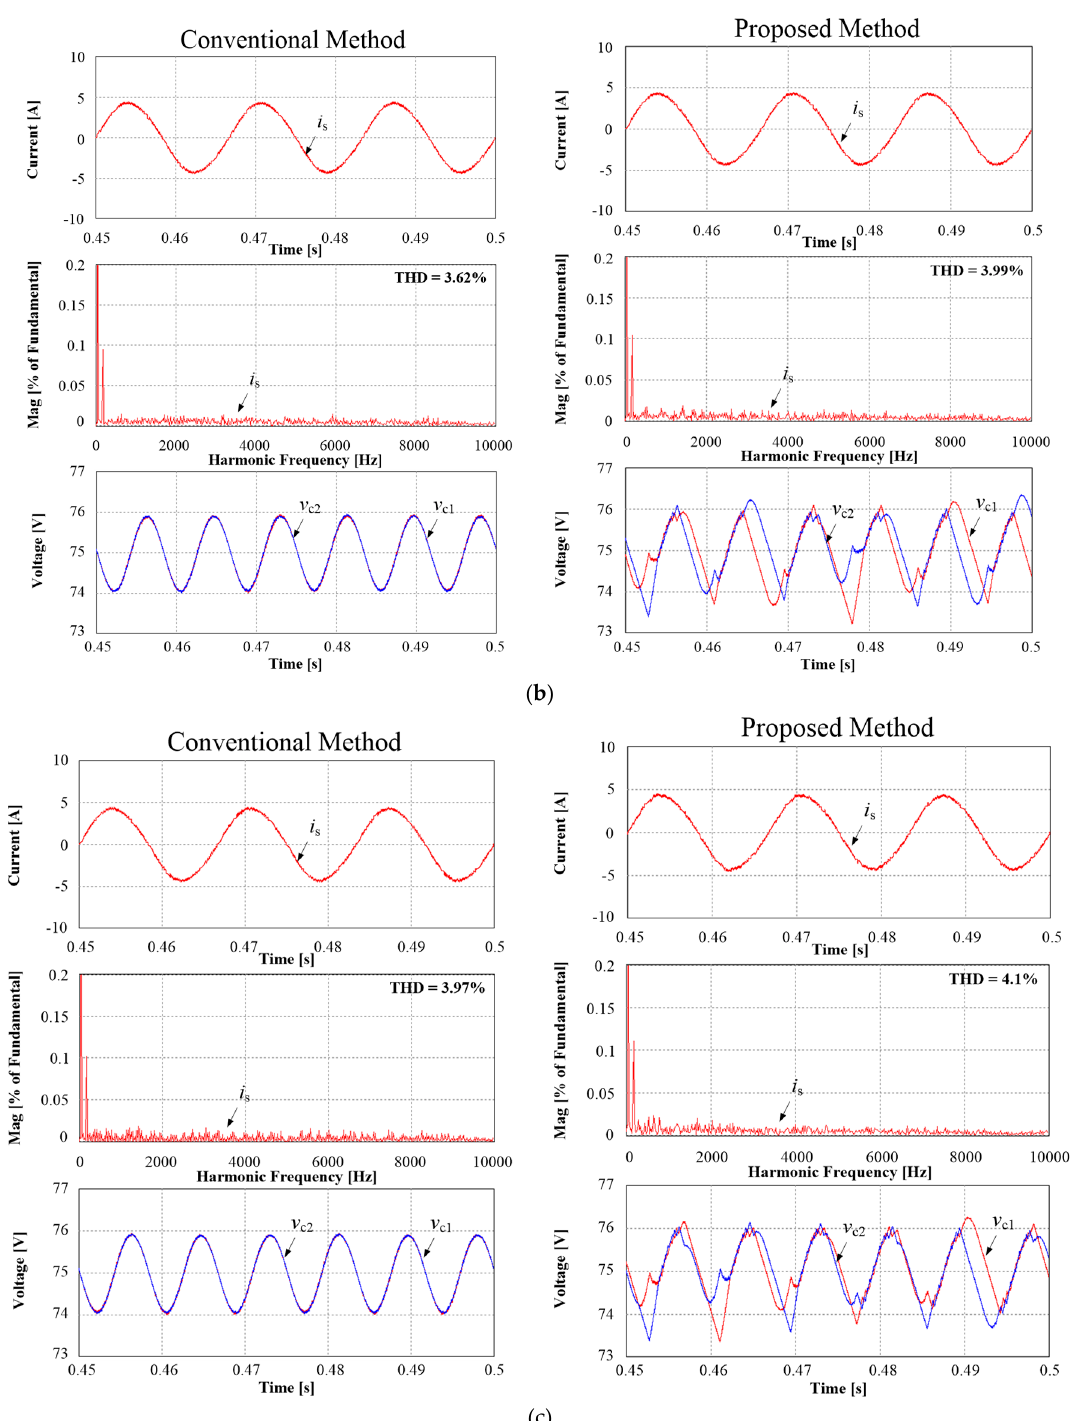
Figure 14. Simulation results of ac source current ( i s ), frequency spectrum of input current ( i s ), and capacitor voltages ( v aN, v bN ) obtained by the conventional and the proposed methods with weighting factor ( a ) λ c = 0.05, ( b ) λ c = 0.5, and ( c ) λ c = 2.